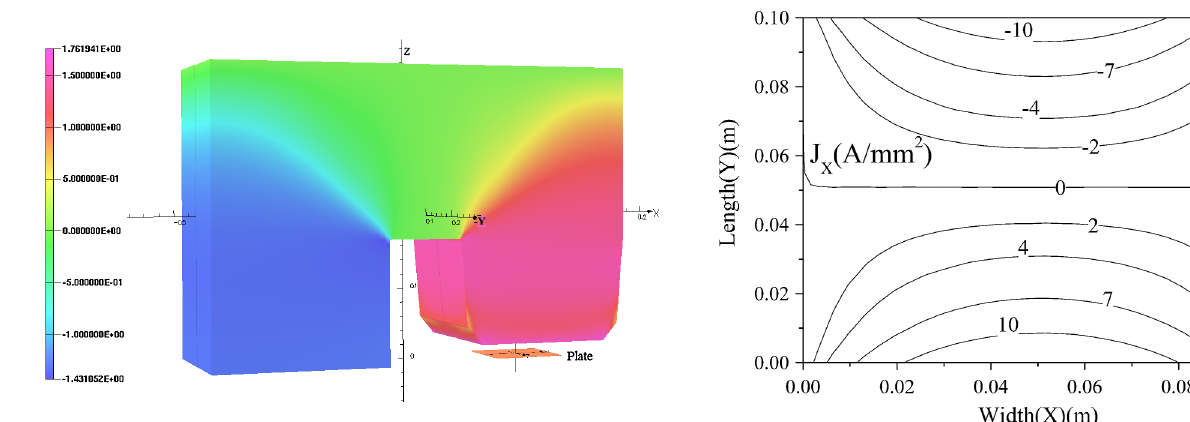
FIG. 5. Contour plot of X component of the eddy current in the SS plate of dimension ð 0 : 1 ; 0 : 1 ; 0 : 002 Þ m 3 for density, j x 50 Hz frequency and 0.923 21 T peak field.